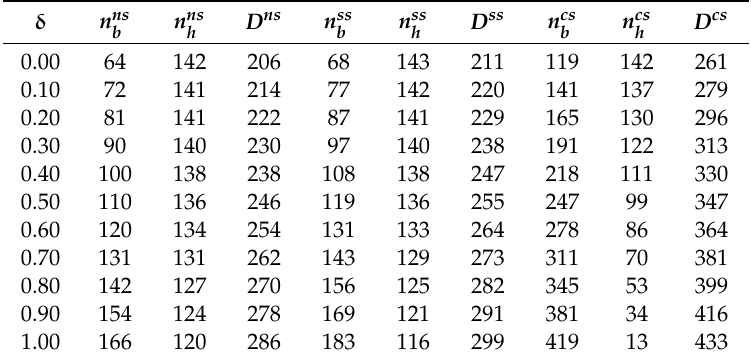
Table 5. Patients visiting number of superior and subordinate hospitals under di ff erent reference price e ff